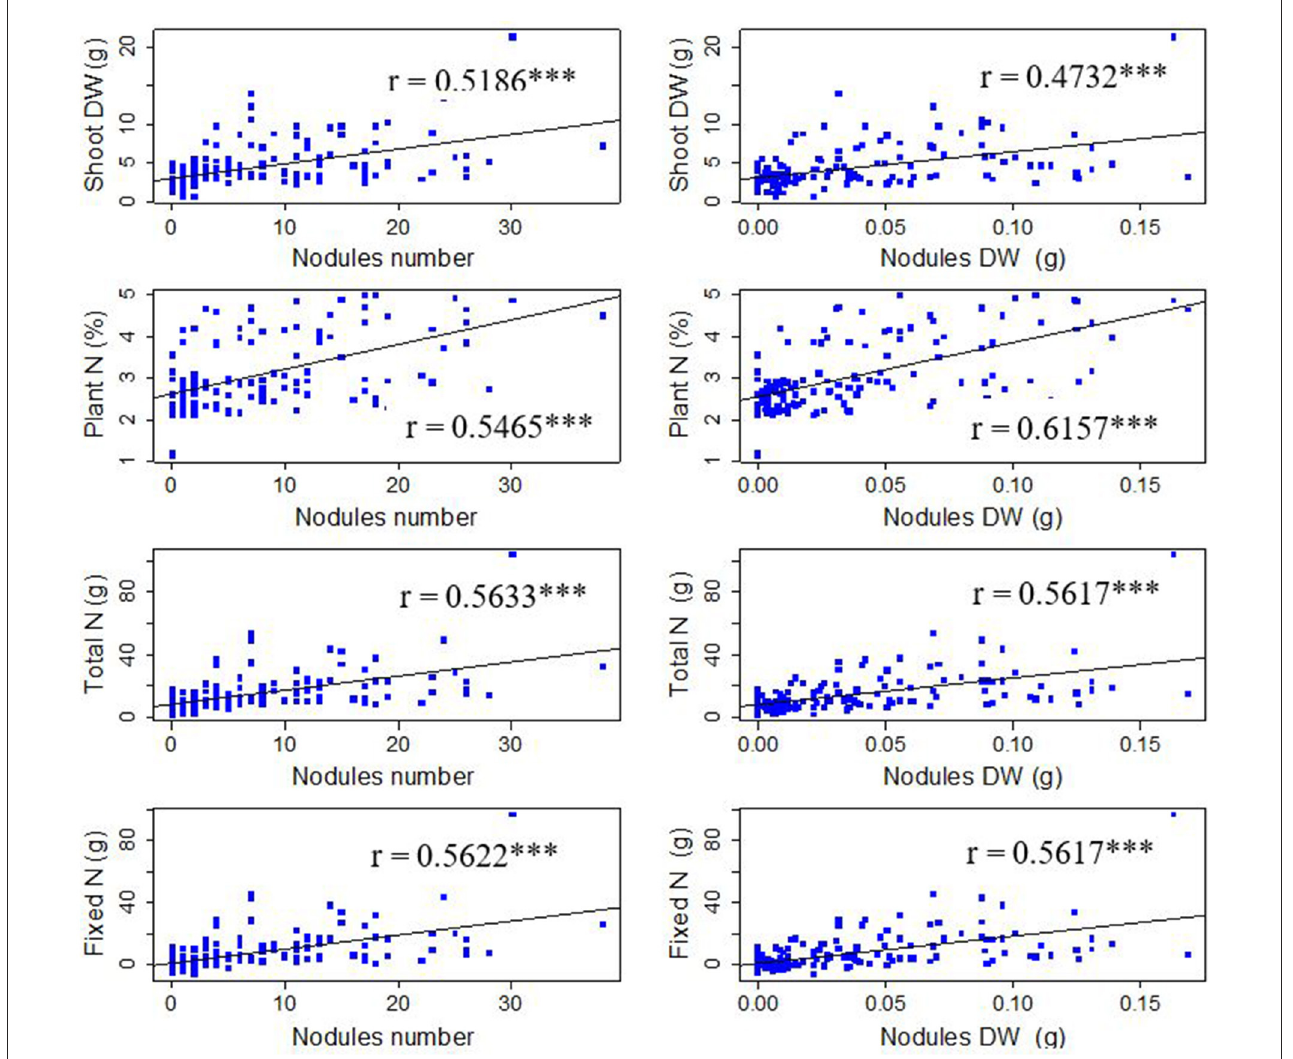
FIGURE6 Trends analysis plots for SNF-related traits (*** significant at 0.001; n = 150, P < 0.001). N, Nitrogen; DW, Dry weight.